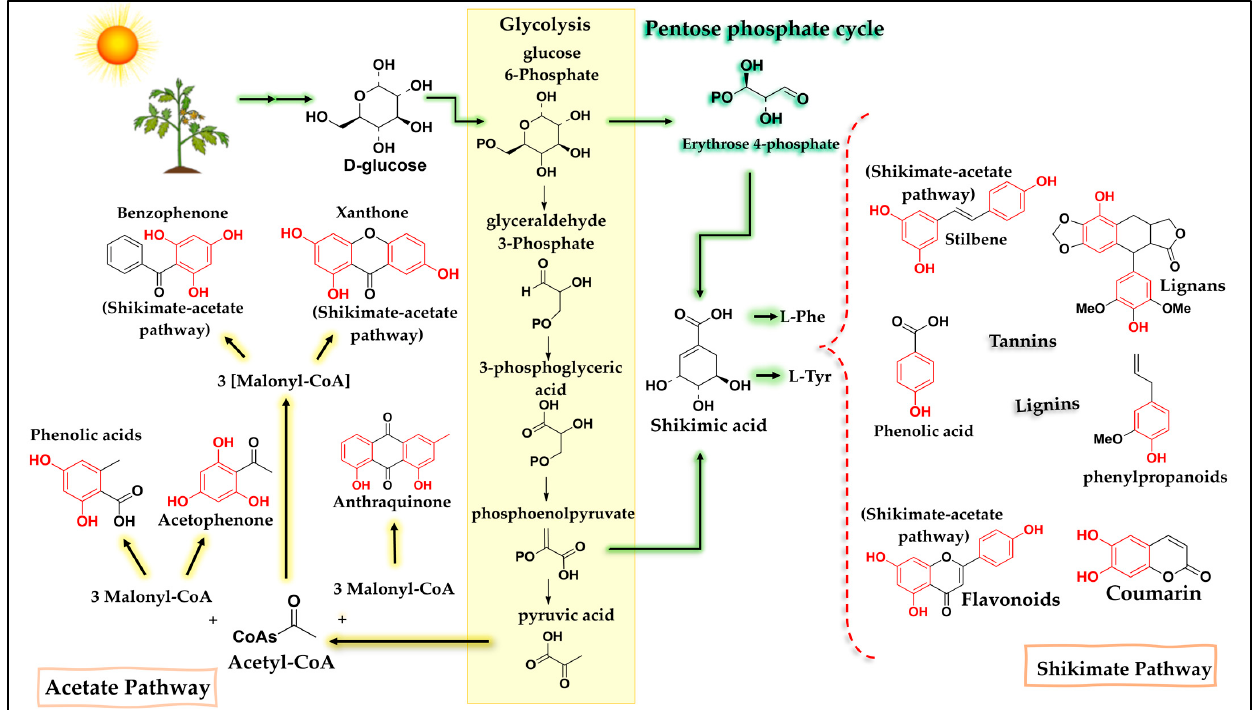
Figure 1. Simplified diagram of the shikimate and acetate pathways, which are responsible for the formation of phenolic compounds. Caption: The shikimate pathway occurs through the reaction between phosphoenolpyruvate and erythrose 4-phosphate, forming shikimic acid and leading to the formation of a variety of phenolic compounds. The acetate pathway occurs through the decarboxylation of pyruvic acid to form acetyl-CoA, which combines with malonyl-CoA units to form phenolic